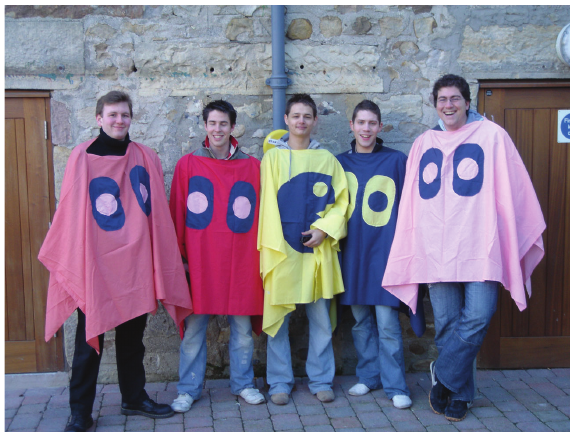
Figure 3: PAC-LAN trial team for 10th of